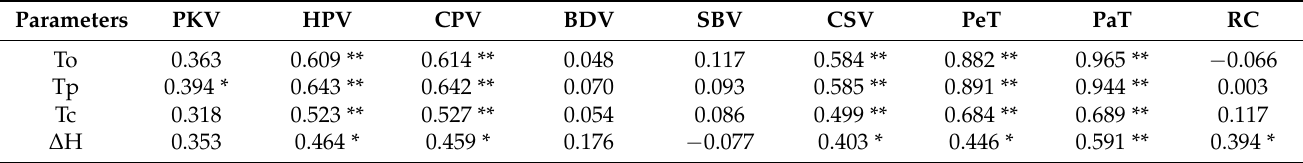
Table 5. Correlation analysis of the physicochemical properties of